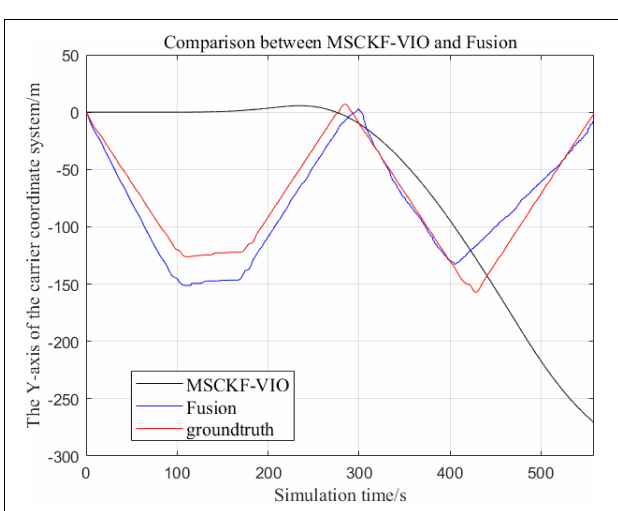
FIGURE 7 | Zoomed-in comparison of the y -axis local trajectories of the fusion algorithm and the MSCKF_VIO algorithm.